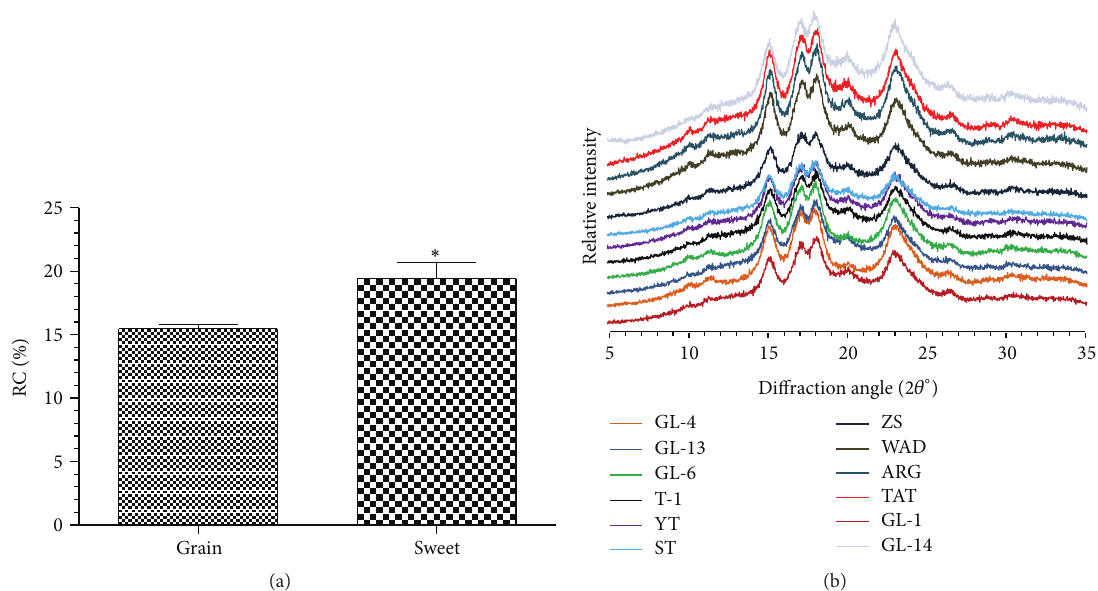
Figure 4: Comparison of relative crystallinity (RC) (a) and XRD spectrograph (b) of starches from sweet and grain varieties. ∗ indicates significant difference ( 𝑝 < 0.05 ) was